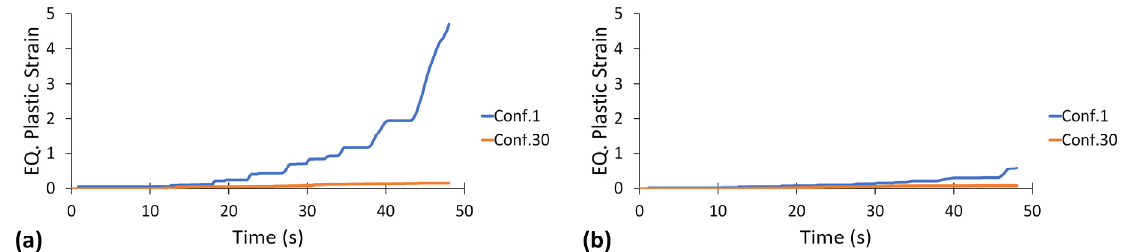
Figure 15. Structural response time histories under Landers earthquake: ( a ) acceleration at the top of the structure, ( b ) acceleration at the top of the fourth substructure, ( c ) acceleration at the top of the third substructure, ( d ) acceleration at the top of the second substructure, ( e ) displacement at the top of the structure, ( f ) displacement at the top of the fourth substructure, and ( g ) displacement at the top of the third substructure and ( h ) displacement at the top of the second substructure. From the time history of the equivalent plastic strain, plastic deformation starts in the column element at (40, 0, 74~40, 0, 74.4) after 1.2 s and in the beam element at (40, 3.25,